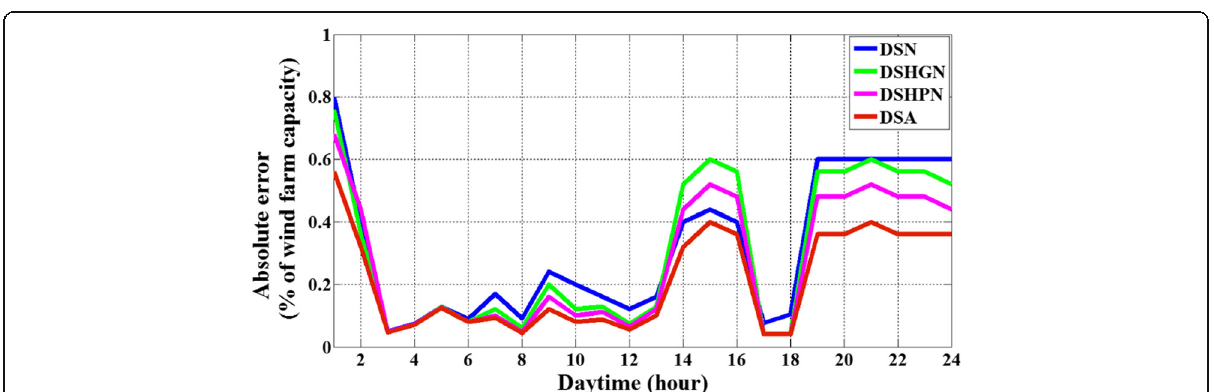
Fig. 10 Normalized absolute values of forecast errors for a summer day